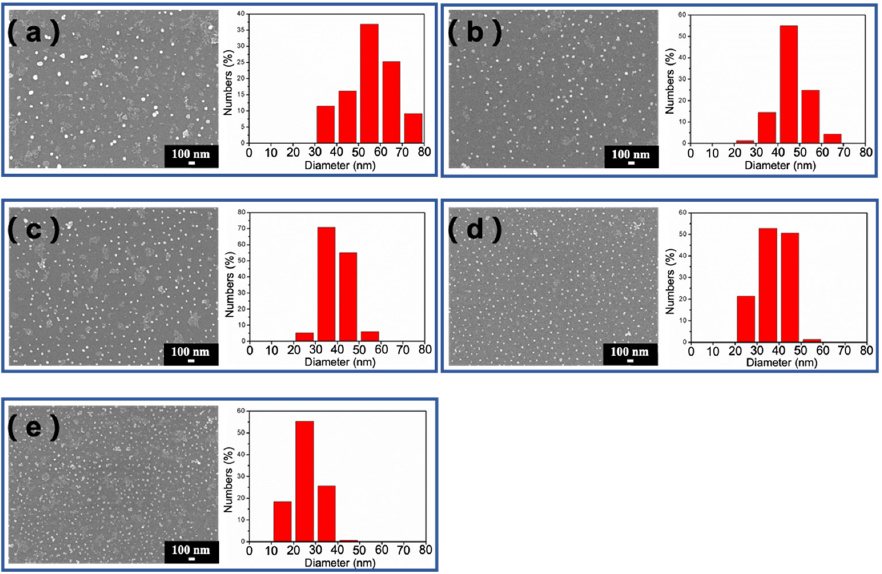
Figure 2. ( a – e ) SEM images of different Fe 3 O 4 @Au NP sizes and their corresponding size distribution (mean diameters of 59.5 ± 10.5 nm, 47.7 ± 7.1 nm, 39.5 ± 5.7 nm, 33.1 ± 5.0 nm, and 26.0 ± 6.0 nm).